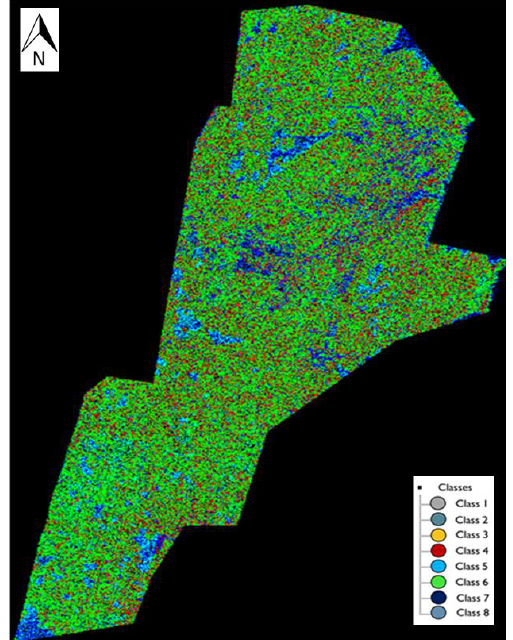
Figure 3. The initial unsupervised classification using H/α